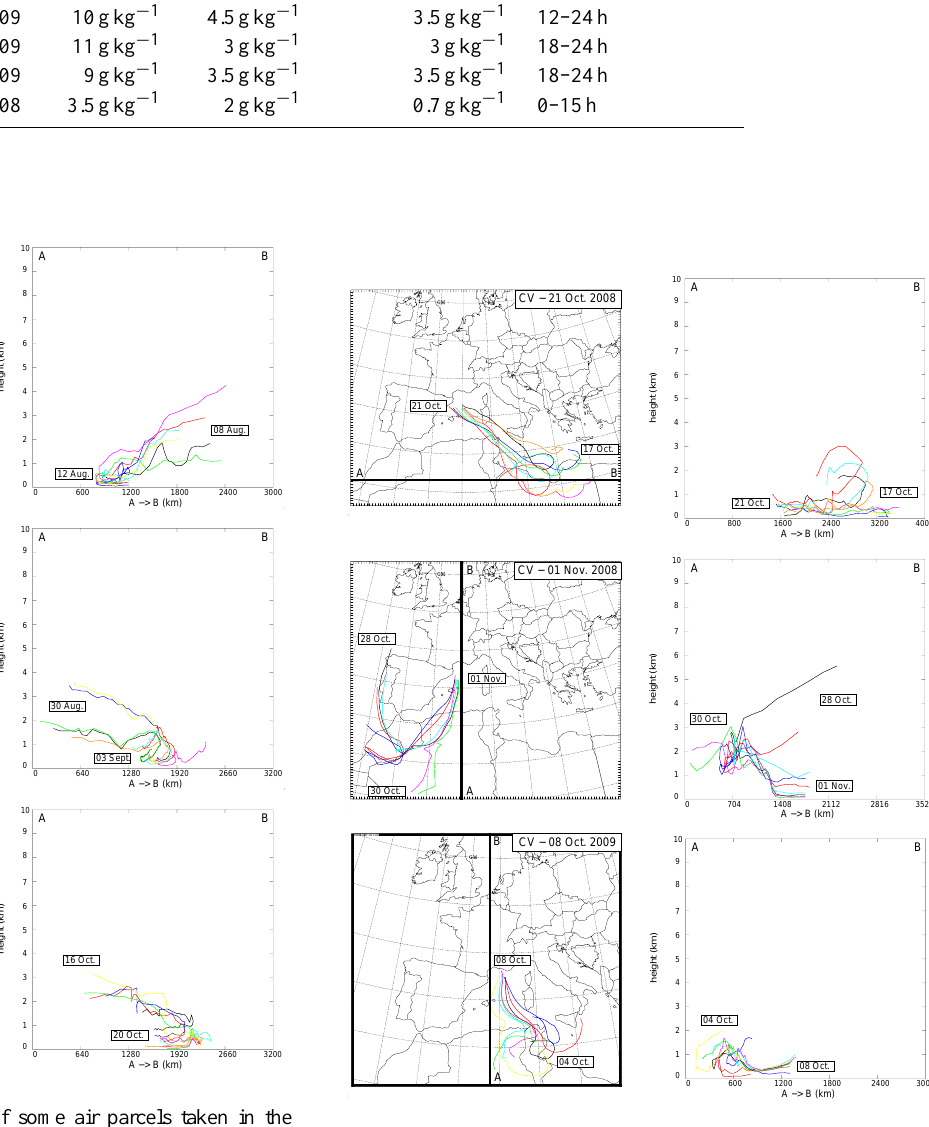
Fig. 14. Same as Fig. 13, but for three other CV cases: the 21 October 2008 (top), the 1 November 2008 (middle) and the 8 October 2009 (bottom). The backward trajectories of the 21 October 2008 and 1 November 2008 cases are performed with the RAI40